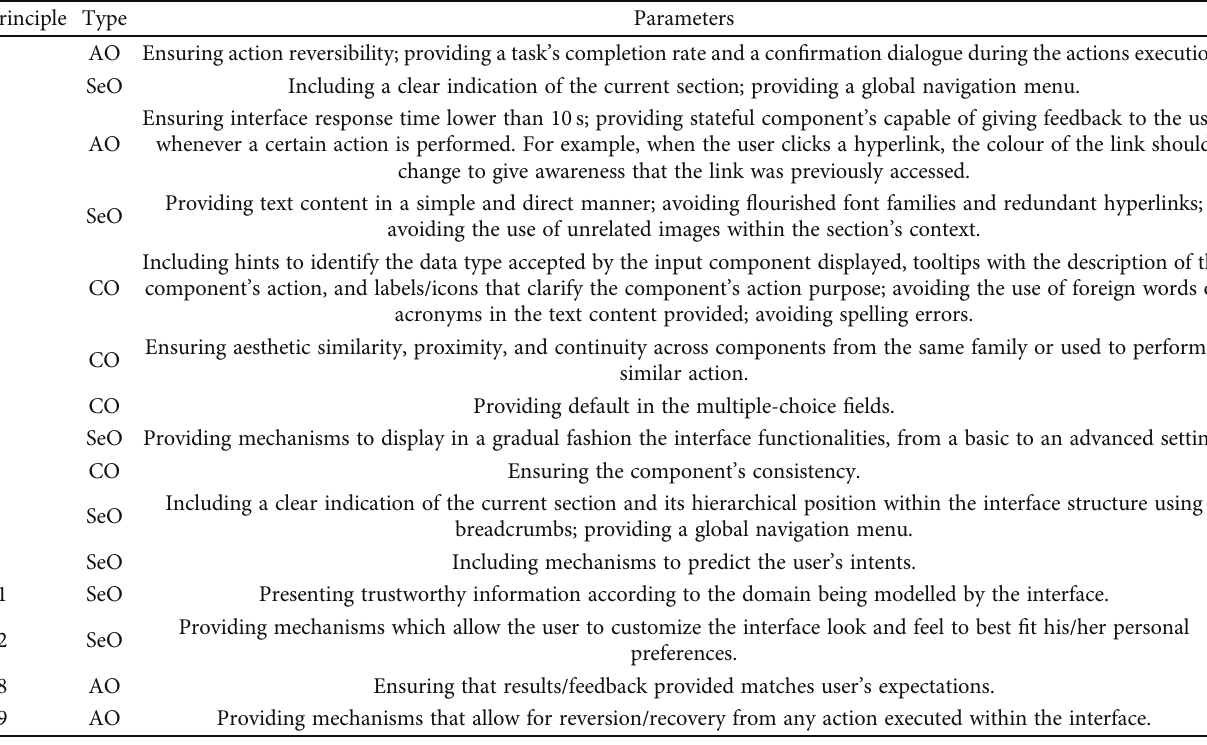
Table 6: Weinschenk and Barker ’ s cognitive principles of parametrization [156 – 161].